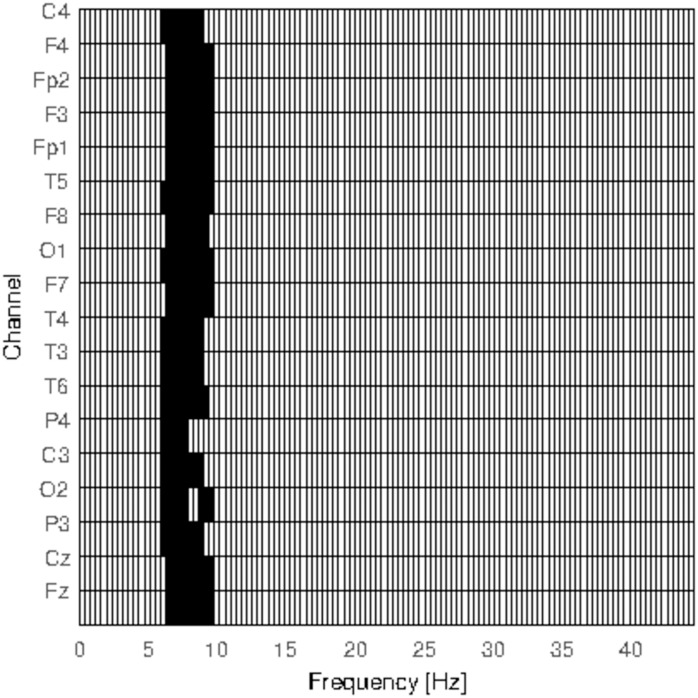
Clusters for the permutation test.Channel and frequency neighbors found by running the clustering stage of the permutation test for the local spectral entropy.